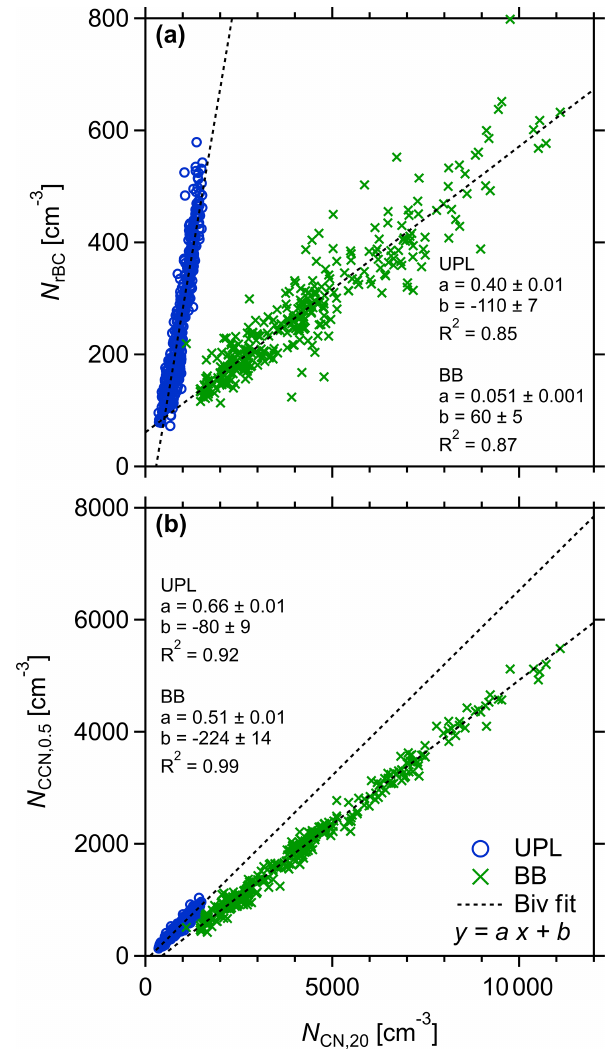
Figure 5. Correlation between (a) rBC particle number concentra- tions ( N rBC ) and total aerosol ( N CN , 20 ) ; and between (b) CCN at S = 0 . 5% ( N CCN , 0 . 5 ) and total aerosol ( N CN , 20 ) in the UPL (blue) and in the fresh biomass burning plume (green). The dashed lines are bivariate linear regressions applied to the data